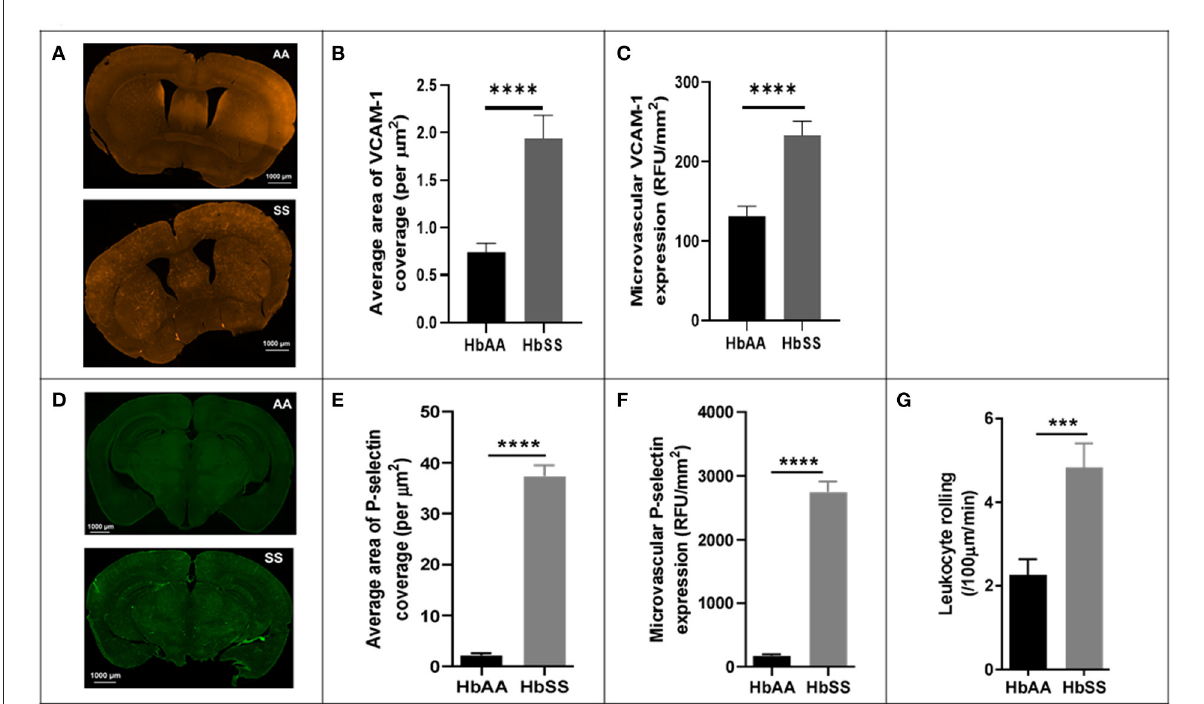
FIGURE3 Adhesion factor expression and the rate of leukocyte adherence are elevated in the brains of sickle cell mice. Fluorophore of interest was isolated to show fluorescent areas representing VCAM-1 deposition along the microvasculature. (A) Representative image of stained tissue sections (50 um thick) from SS (bottom) and AA (top) mice. Areas of fluorescence indicate VCAM-1 deposition. These images were taken after spectral unmixing but prior to transferring to ImageJ for binarizing and overlaying masks. Adhesion factor expression was measured by analyzing fluorescence intensity and reported as relative fluorescence units (RFU) per millimeter squared of brain tissue. (B) Average area of VCAM-1 coverage per µ m 2 (C) VCAM-1 expression compared to controls. (D) Representative image of stained tissue sections (50 um thick) from SS (bottom) and AA (top) mice. Fluorophore of interest was isolated to show fluorescent areas representing P-selectin deposition along the microvasculature. Areas of fluorescence indicate P-selectin deposition. (E) Average area of P-selectin coverage per µ m 2 . (F) microvascular P-selectin expression (RFU/mm 2 ). (G) Leukocyte adherence (defined as lasting two seconds or more) per 100 µ m length of vessel per minute was higher in sickle cell mice ( p < 0.001) (AA: n = 5; SS: n = 7). Error bars are standard error of means (SEM). *** p ≤ 0.001; **** p ≤ 0.0001. Mean comparisons done using Welch’s corrected t-test. Results here are only from the mice in the baseline group. For VCAM-1 analysis, AA = 184 brain slices and SS = 215 brain slices, while for P-selectin analysis, AA = 189 brain slices and SS = 165 brain slices. For leukocyte rolling, AA = average of ∼ 194 vessel segments; SS = average of ∼ 390 vessel